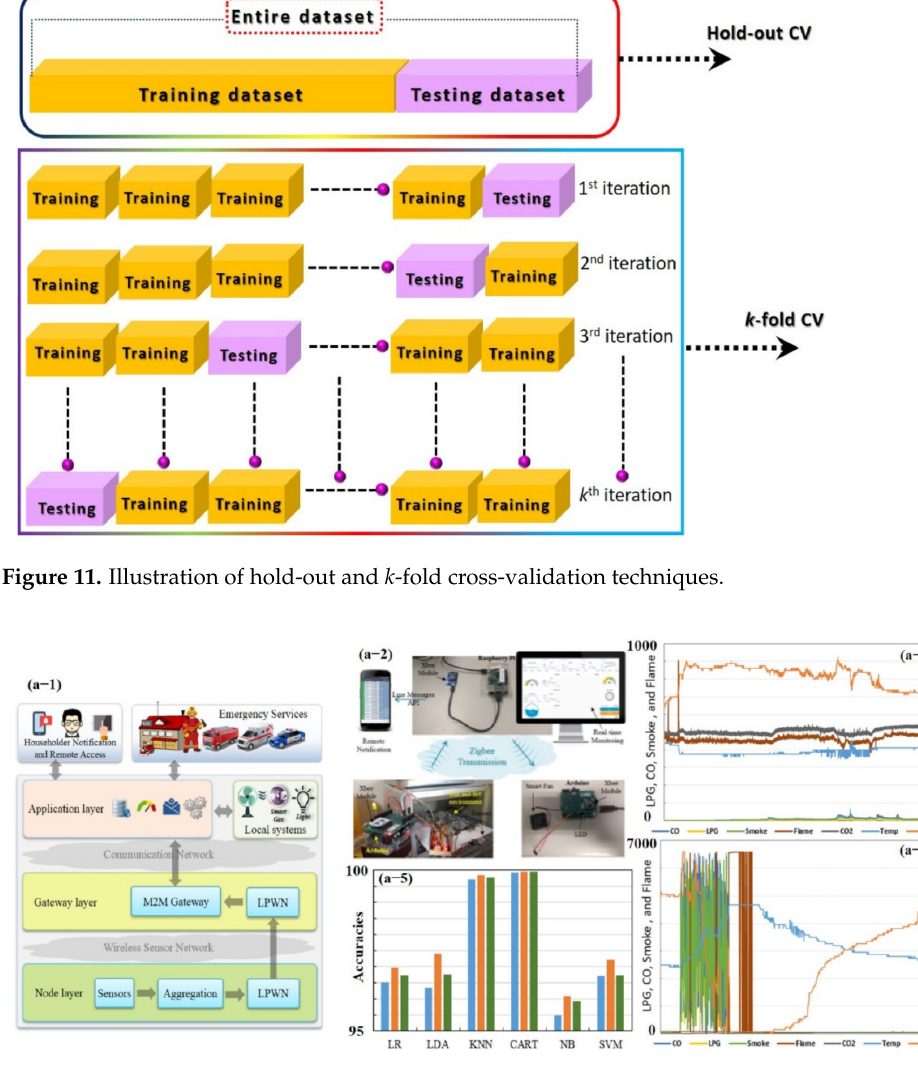
Figure 12. Early fire detection in smart homes using machine learning: (a-1) overall system overview, (a-2) whole hardware and experimental setup, (a-3) sensor measurements taken under usual con- ditions, (a-4) sensor measurements taken under extreme conditions, and (a-5) prediction accuracy histogram before and after replacing the missing values with the mean values computed from the training data. Reproduced with permission from [73], copyright 2020